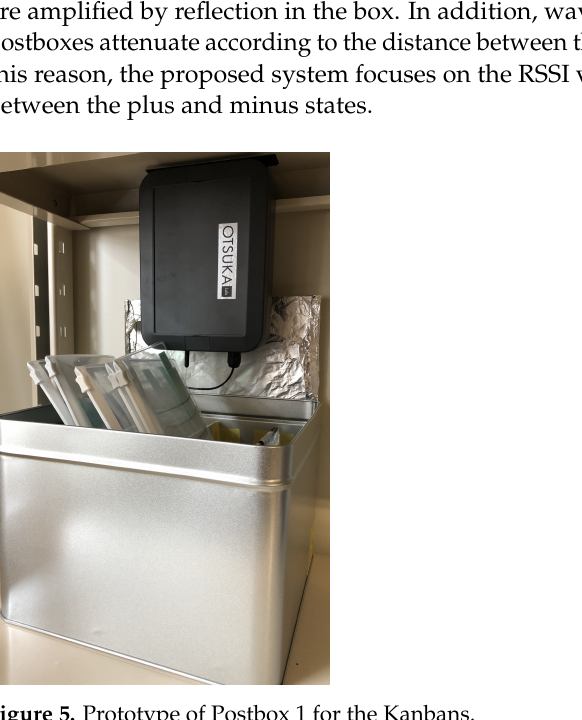
Figure 5. Prototype of Postbox 1 for the